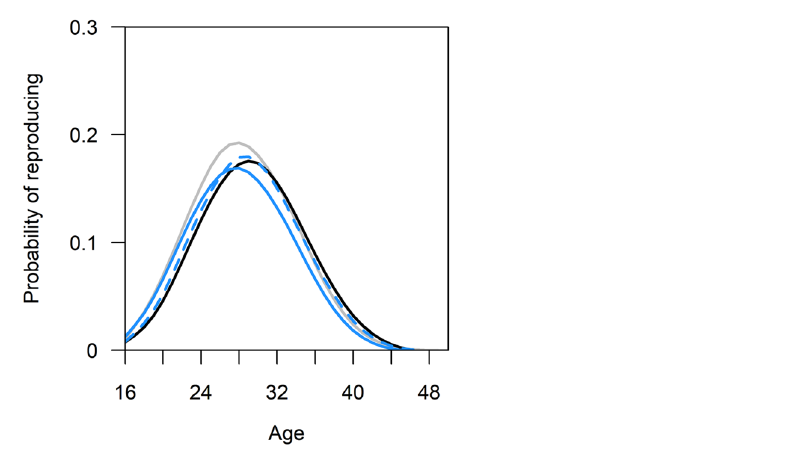
Figure 1. Age-specific probability of reproducing for the first time by presence of mother or mother-in-law. Smoothing splines fitted from model-predicted reproduction probabilities using smooth.spline function. Grey line = neither mother nor mother-in-law alive, black = both alive, solid blue = mother alive, dashed blue = mother- in-law alive. This model controlled for birth order and number of living